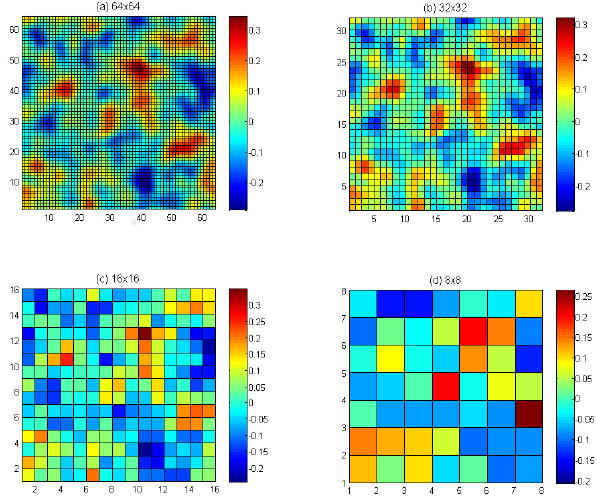
Figure 10. The rough surfaces for four successive grids. They indicate similar shapes.